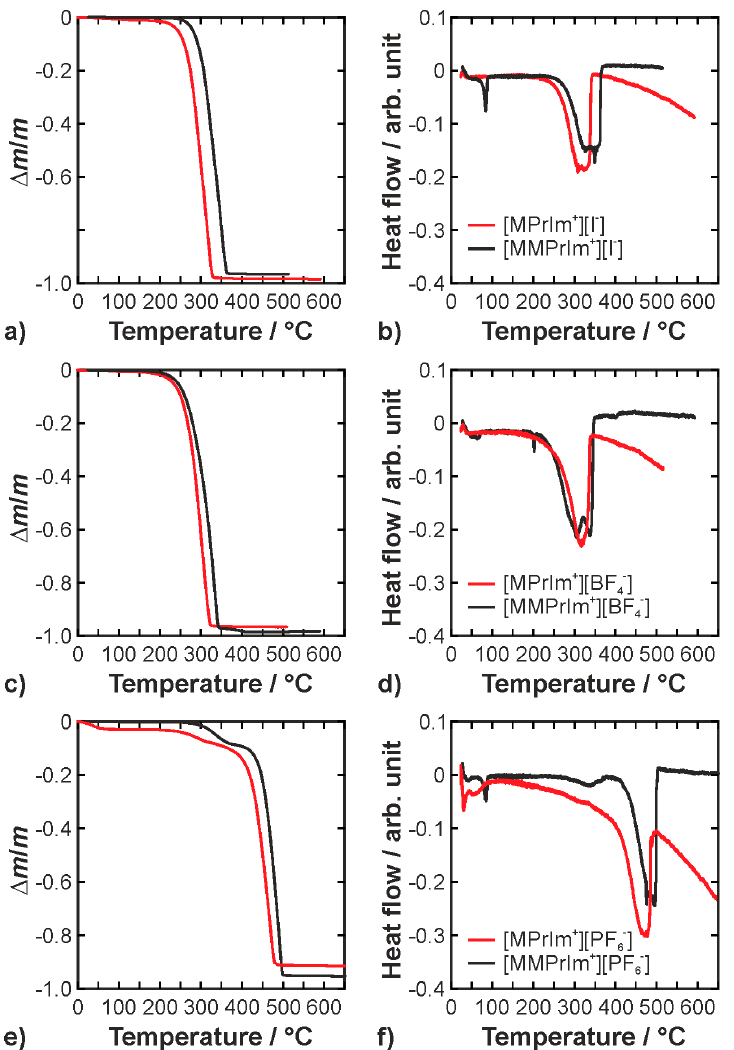
Figure 2. TGA (panels ( a , c , e )) and differential scanning calorimetry (DSC) (panels ( b , d , f )) curves of the C2-protonated versus C2-methylated imidazolium-based ionic liquids. The legends in the diagrams on the right are also valid for the corresponding diagrams on the left; ( a ) and ( b ) show the data of the iodide ILs; ( c ) and ( d ) show the data of the tetrafluoroborate ILs; ( e ) and ( f ) show the data of the hexafluorophosphate ILs.